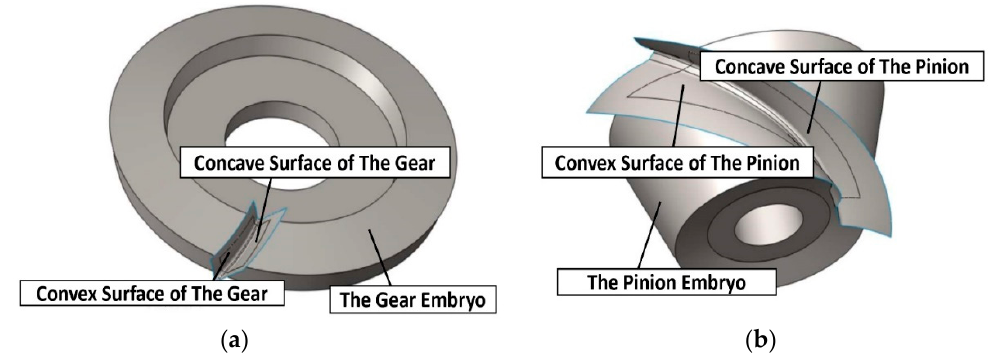
Figure 7. Generation process of spiral bevel gear pair: ( a ) generation process of gear, and ( b ) generation process of pinion.